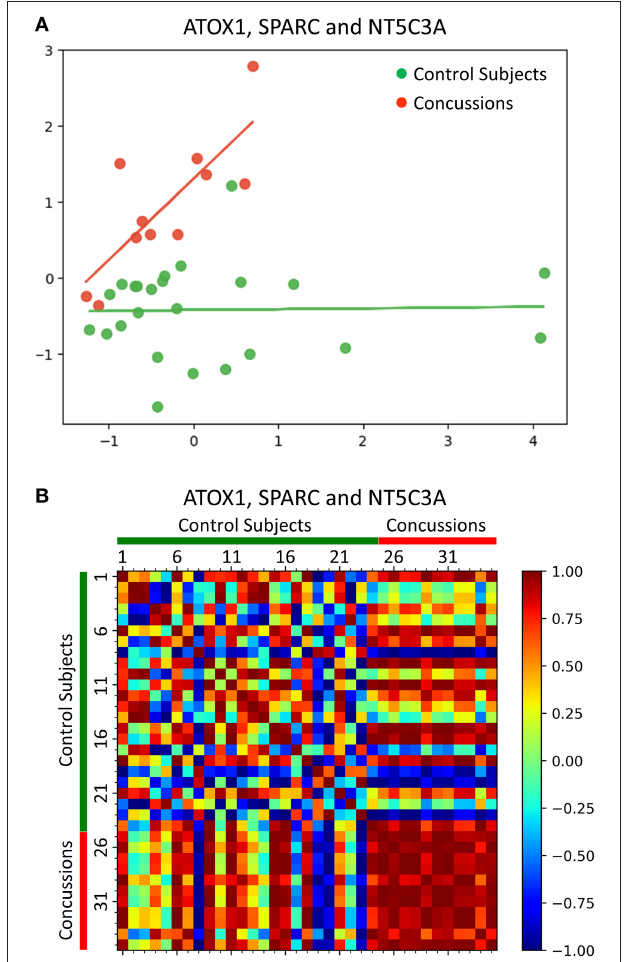
FIGURE 3 | Machine learning analyses of a 3-protein combination for concussion diagnosis. (A) PCA showed a distinct separation of the concussed athletes when compared to their matched healthy control subjects, based on the reduction of the 3-protein feature set (ATOX1, SPARC and NT5C3A) down to two dimensions. (B) Pearson correlation coefficients heatmap using the 3-protein feature set (ATOX1, SPARC and NT5C3A) showed that concussed athletes were highly similar (red) when compared to their matched healthy control subjects, which were highly dissimilar.